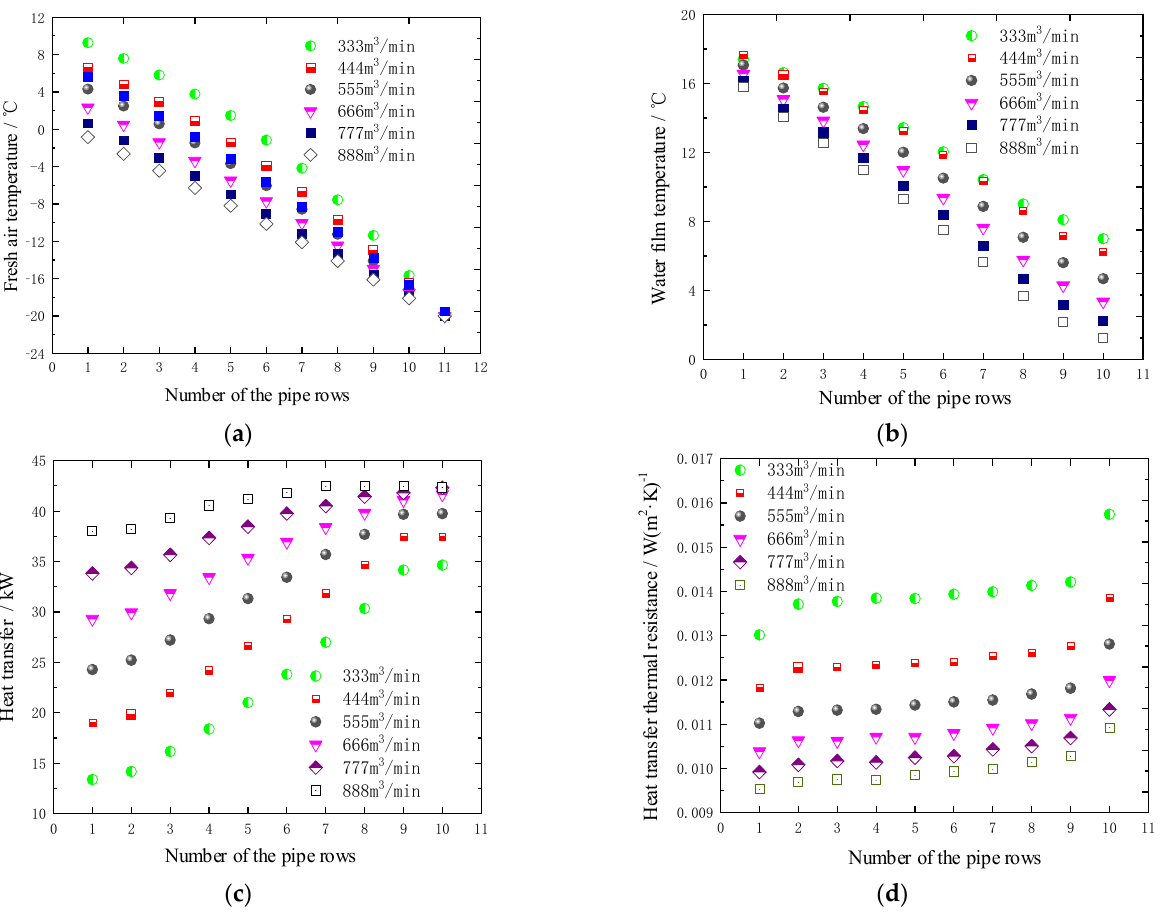
Figure 8. Numerical calculation parameters of heat transfer process of gravity heat pipe: ( a ) fresh air temperature distribution, ( b ) water film temperature distribution, ( c ) heat transfer distribution, ( d ) heat transfer thermal resistance distribution.